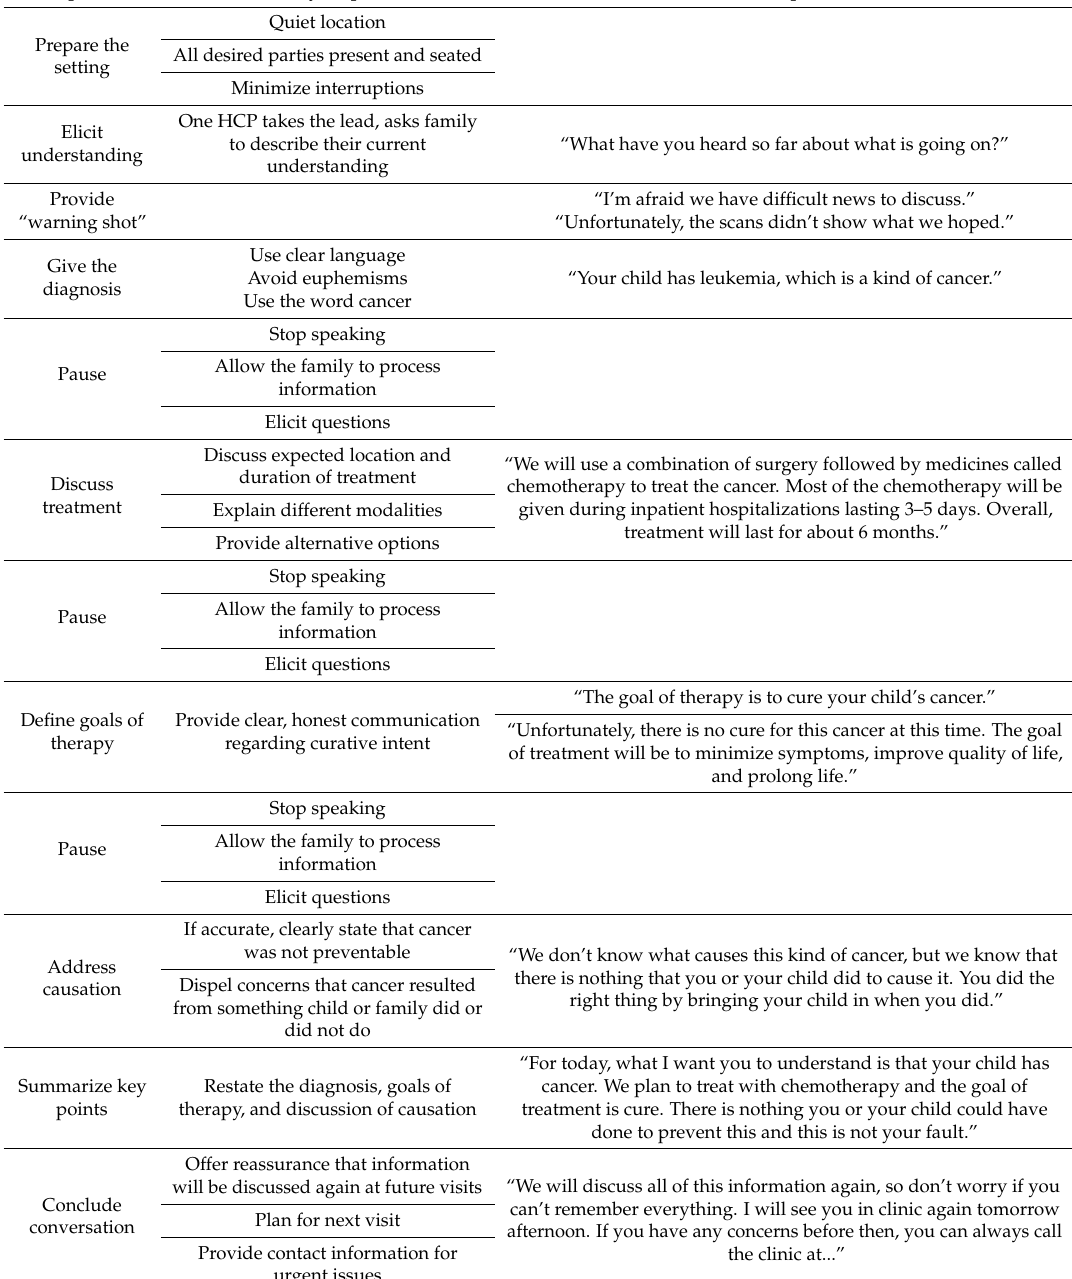
Table 2. A structured approach to diagnosis